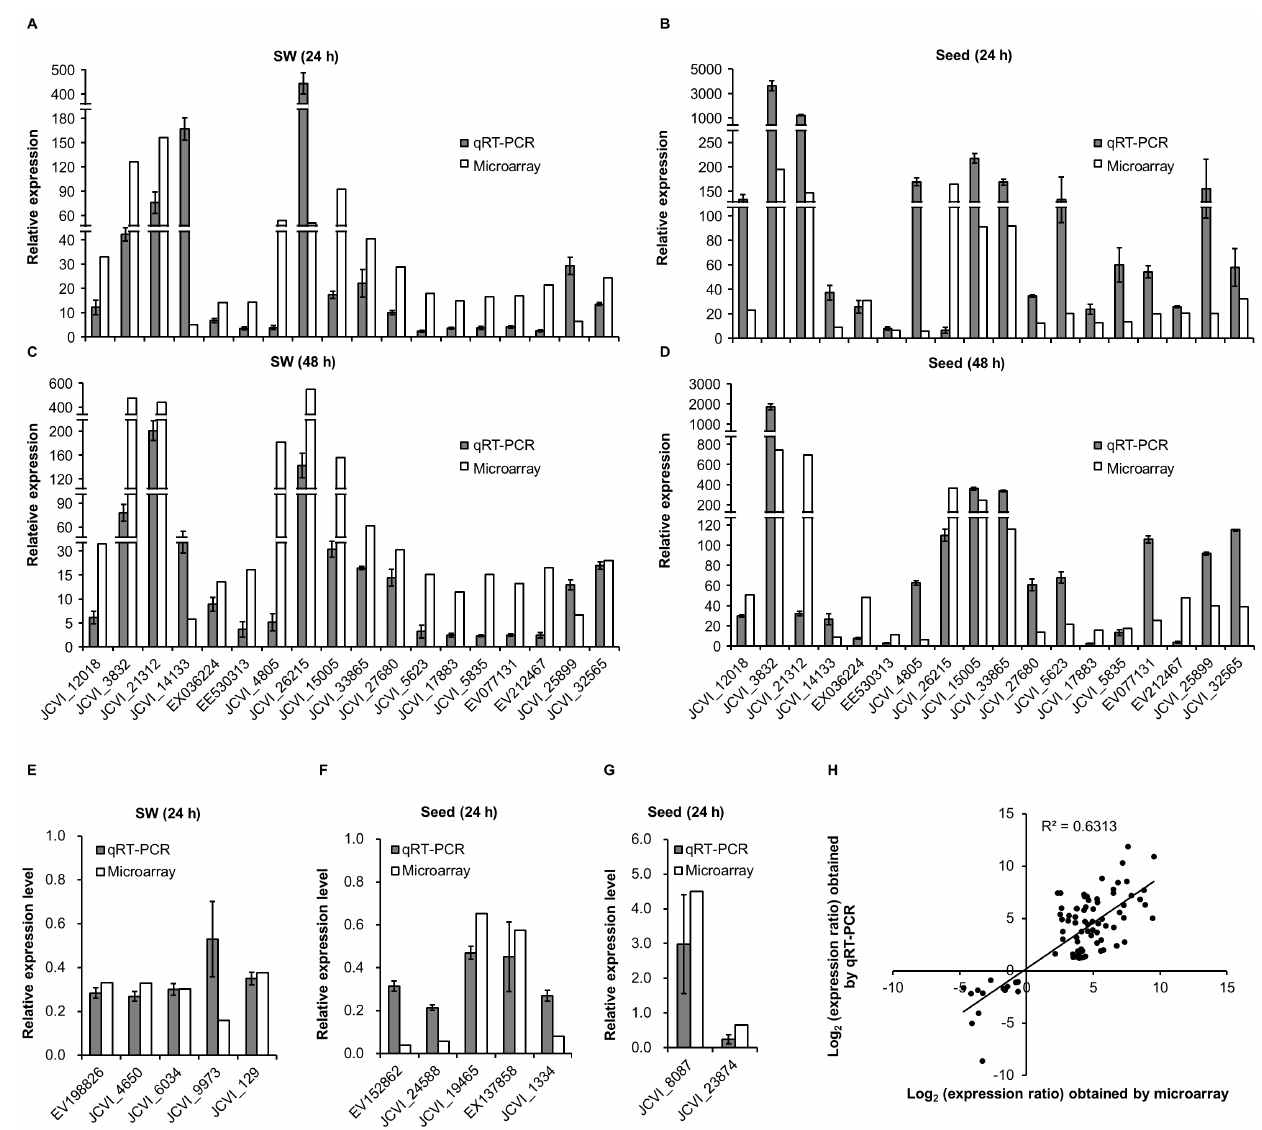
Figure 7. qRT-PCR validation of differential expression. Relative expression levels of 18 up-regulated genes were detected in the SW and seeds sampled at 24 h (A and B) and 48 h (C and D) after heat treatment. 10 down-regulated genes, of which 5 involving glucosinolate metabolism and another 5 associated with flavonoid synthesis were analyzed in the SW (E) and seeds (F) at 24 h after treatment respectively. Two genes may responsible for lipid synthesis were also detected in seeds (G). (H) Correlation of the gene expression ratios obtained from qRT-PCR and microarray data. The qRT-PCR log 2 value of the expression ratio (y-axis) has been plotted against the value from the microarray (x-axis). The results of all the tested genes were listed in detail in Table S9. Data were collected from three biological replicates and three technical replicates for each